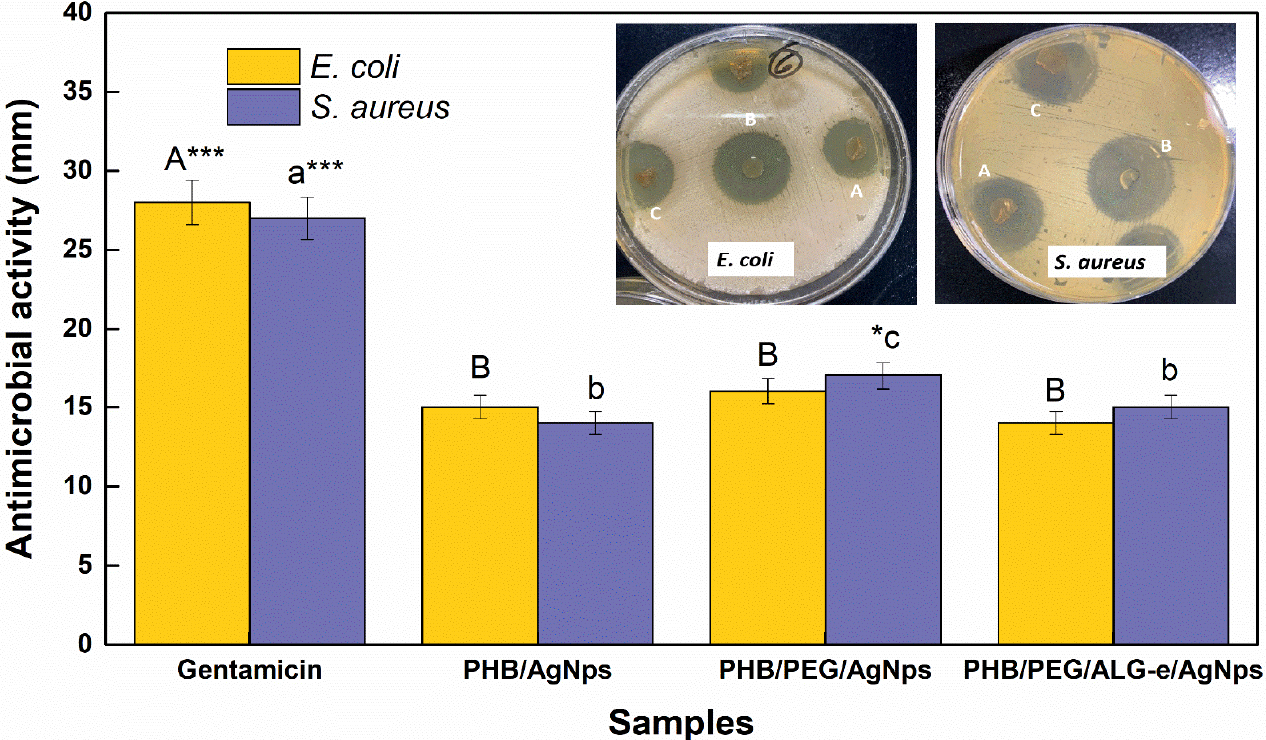
Figure 8. Antimicrobial activity of PHB-based blends loaded with AgNPs. The inserted images show one representative antimicrobial inhibition halo generated by A-PHB/AgNPs, B-PHB/PEG/AgNPs, and C-PHB/PEG/ALG-e/AgNPs against E. coli and S. aureus microorganisms. The statistically significant differences between the samples have been identified with different group letters. * and *** mean that there were significance levels p < 0.05 or p < 0.001, respectively.